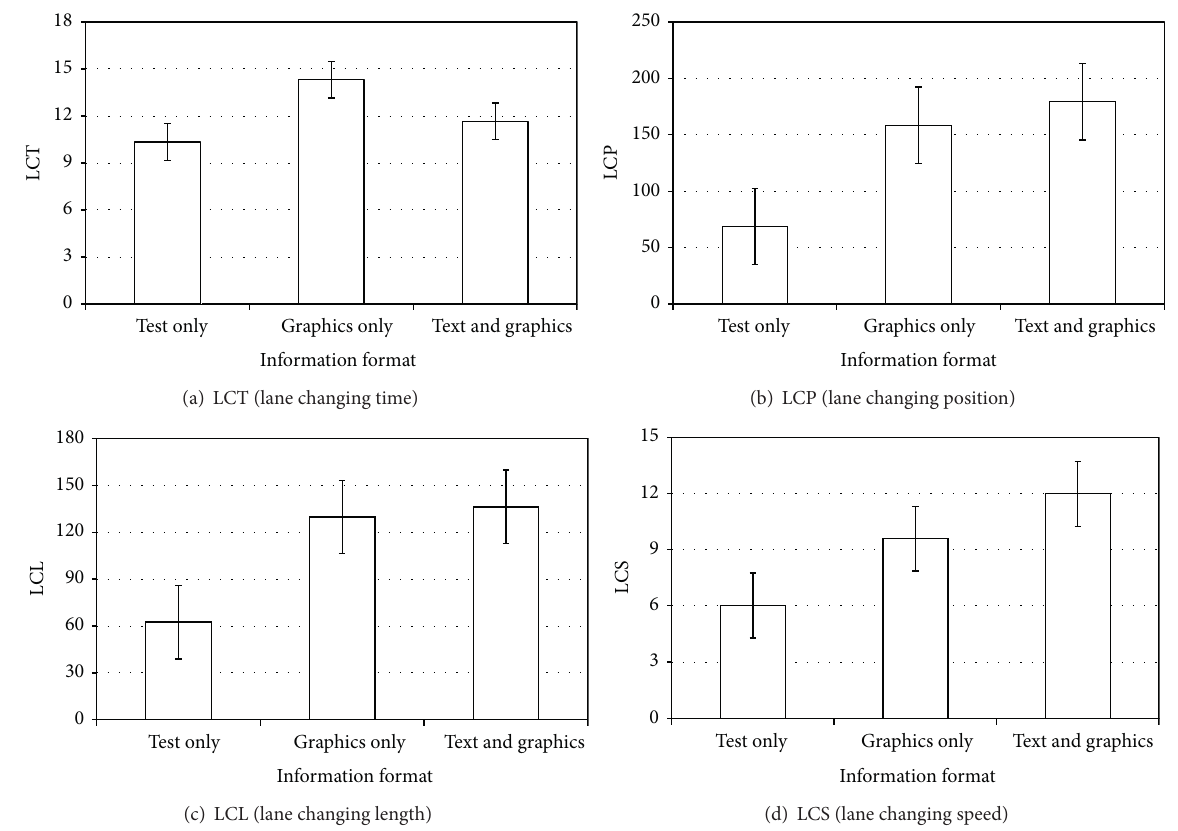
Figure 7: The influence of the VMS information formats on LCT, LCP, LCS, and LCA.